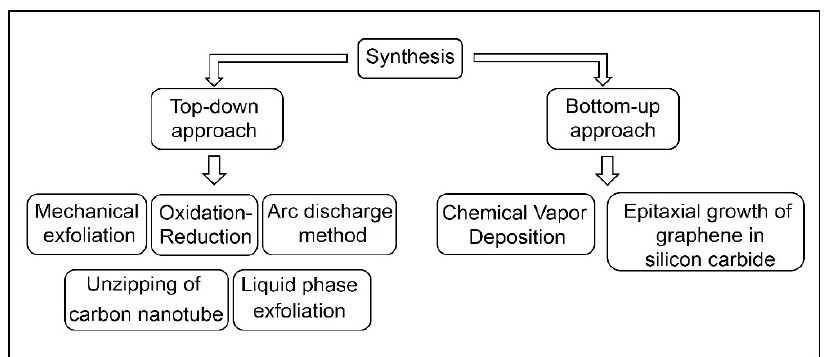
Figure 3. Schematic diagram showing synthesis methods [40].